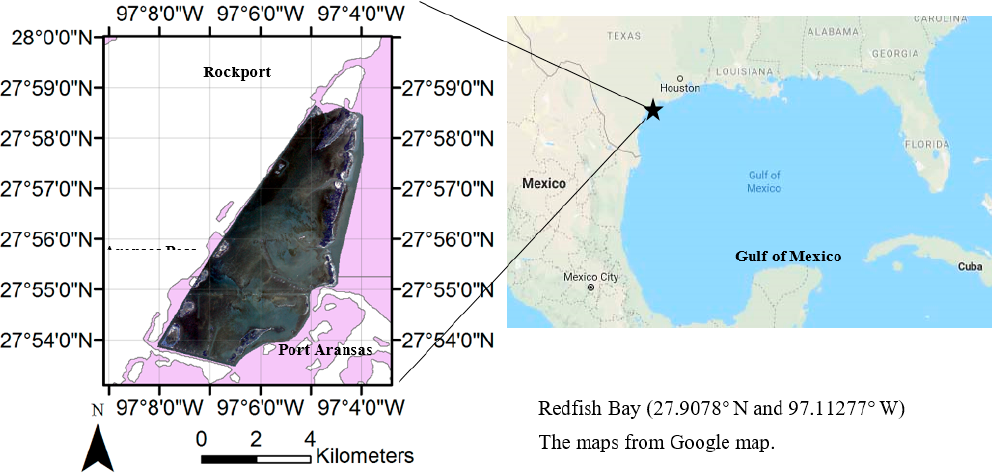
Figure 1. Location of the study site.